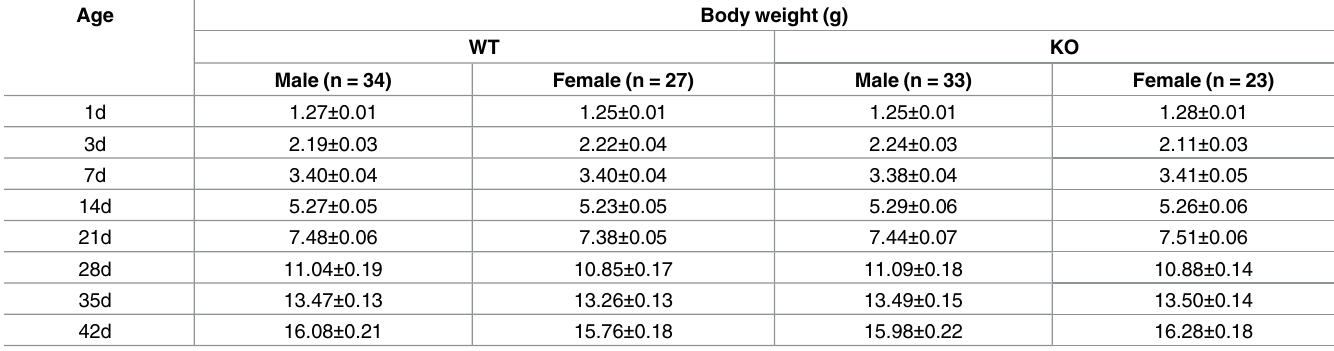
Note: The values represent the mean ± standard deviate on. One-way analysis of variance and pairwise comparisons were performed, and no significant differences between KO and WT mice were observed (P >